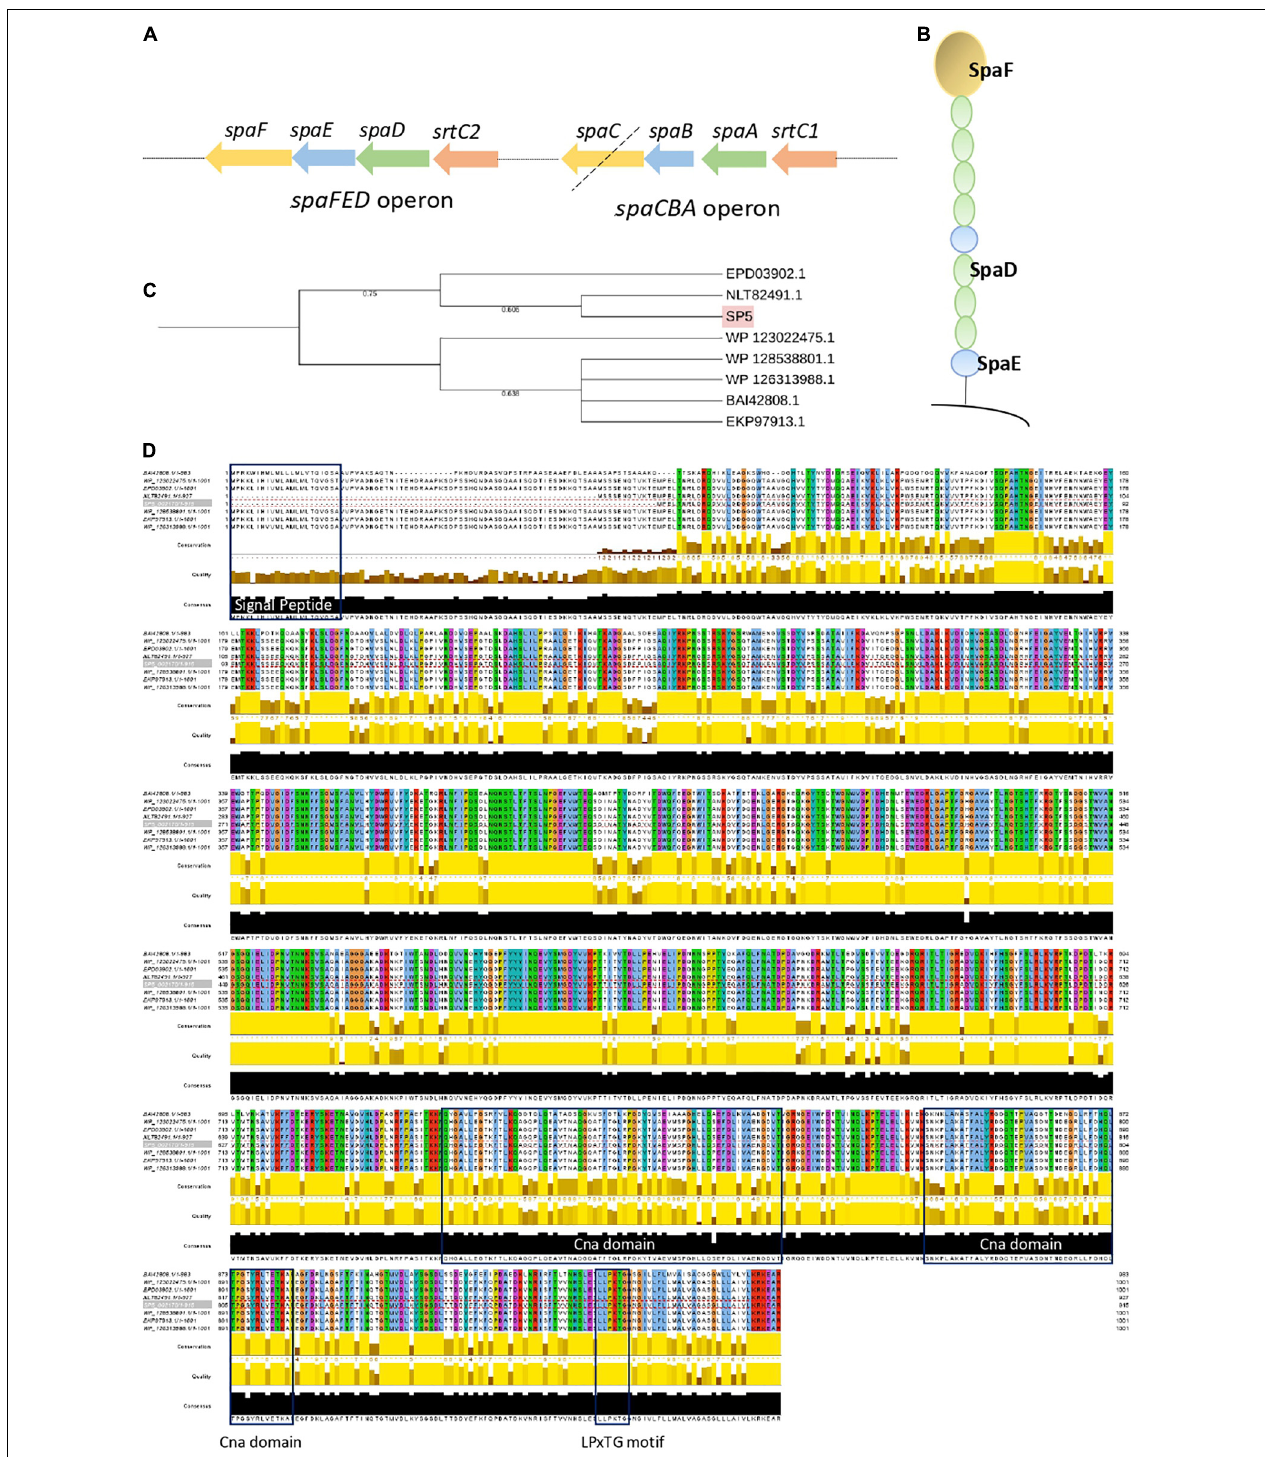
FIGURE 6 | Analysis of the spaCBA and spaFED cluster encoded in the genome of Lc. paracasei SP5. (A) Graphical depiction of the spaCBA and spaFED and pili clusters annotated by PGAP in the genome of Lc. paracasei SP5. The black dotted line signifies that spaC is a pseudogene. (B) Graphical depiction of the spaFED pilus. (C) Neighbor-Joining phylogenetic tree of Lc. paracasei (EPD03902.1, NLT82491.1, WP_123022475.1, WP_128538801.1, WP_126313988.1) and Lc. rhamnosus GG (BAI42808.1) putative spaF gene sequences. Gene alignment was performed using ClustalW and the tree was constructed on the iTol server. Highlighted in pink is the spaF gene sequence of Lc. paracasei SP5 (D) Visualization of spaF alignment was performed using Jalview. Blue boxes indicate the N-terminal signal peptide, two Cna domains (669–735 aa, 764–818 aa), and a C-terminal LPxTG motif.